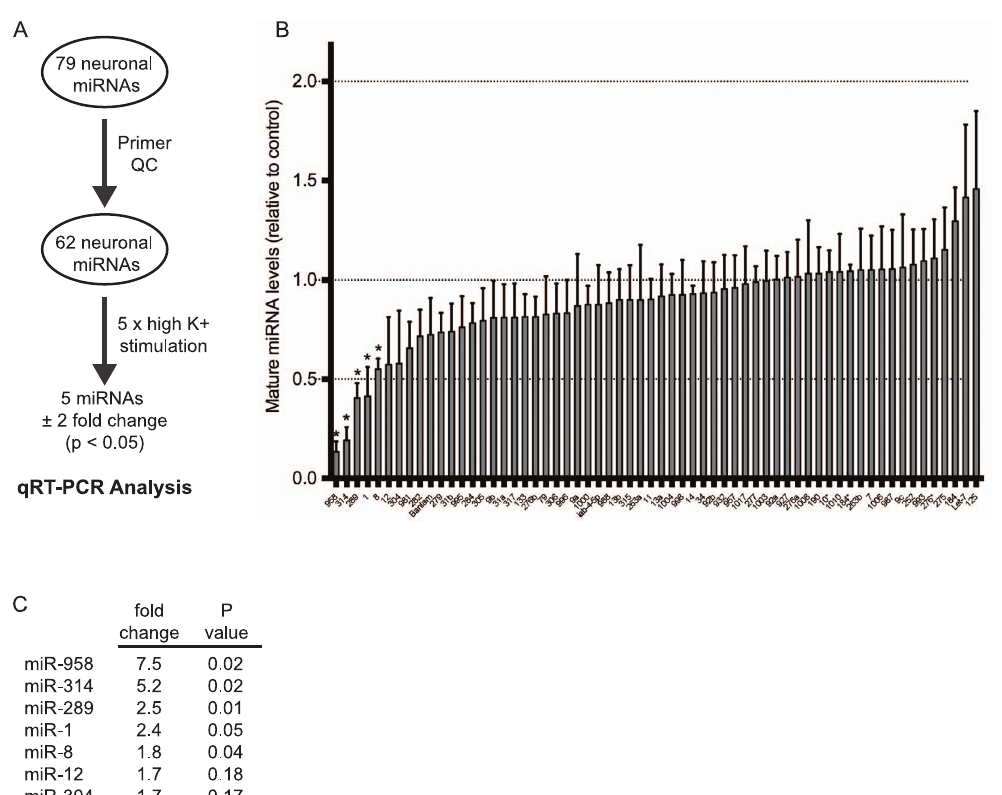
Figure 3. miRs-1, -8, -289, -314, and -958 are rapidly downregulated by activity. (A) Flowchart showing RT-qPCR analysis. 62 of 79 mature neuronal miRNAs were screened by RT-qPCR (see methods). (B) Five miRNAs were determined to exhibit either a 2-fold or statistically significant downregulation in expression levels following spaced high K + depolarization. Error bars indicate the mean 6 SEM. STATISTICS: One-way ANOVA with a Tukey’s post-hoc test (n=3 replicates). * p , 0.05. (C) Table showing fold downregulation and p-values for each activity-regulated miRNA. While not statistically significant, miRs-12 and -304 show a 1.7-fold activity-dependent downregulation. miRs-12 and -304 are both located in the miR-12/304/ 283 cluster. copy of the miR-8 sponge was driven in larval motor neurons (Figure 4C; Figure S2C; UAS-miR-8SP x C380-Gal4 ; 31% decrease; p , 0.0001). Together, these data suggest that miRs-8, -289, and/